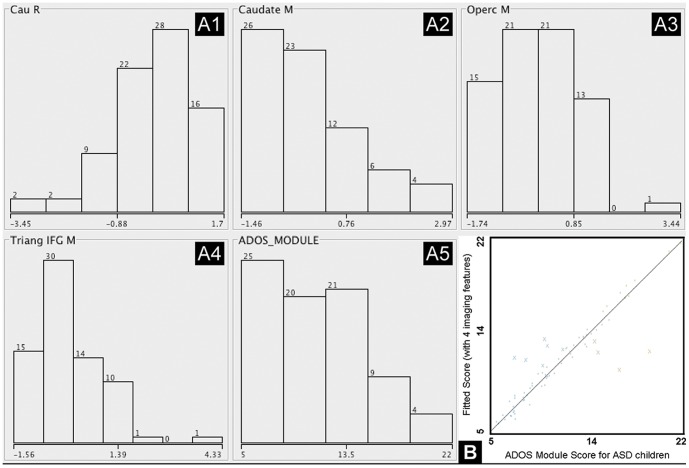
Kstar, an instance (similarity) based classifier for regression analysis had the greatest prediction power for ADOS module score for ASD children among all the regressors combining 4 selected imaging features.A1–A4: standardized histogram distribution showing x-axis as the z-scores of each feature and y-axis being the frequency. A1-right caudate volume, A2-average Z of caudate fcMRI, A3-average Z of IFG opercularis fcMRI, A4-average Z of IFG triangularis fcMRI. A5: phenotypic ADOS module score histogram distribution with x-axis as the original score and y-axis being the frequency. B: The correlation coefficient between integrated imaging features and ADOS module score improved largely from −0.64 based on single best imaging feature to 0.95 combining 4 imaging features. The fitted score using Kstar classifier with 4 selected imaging features showed a tight coupling (linear slope = 1; r = 0.95, P<0.0001) with the original ADOS module score with only a few outliers.